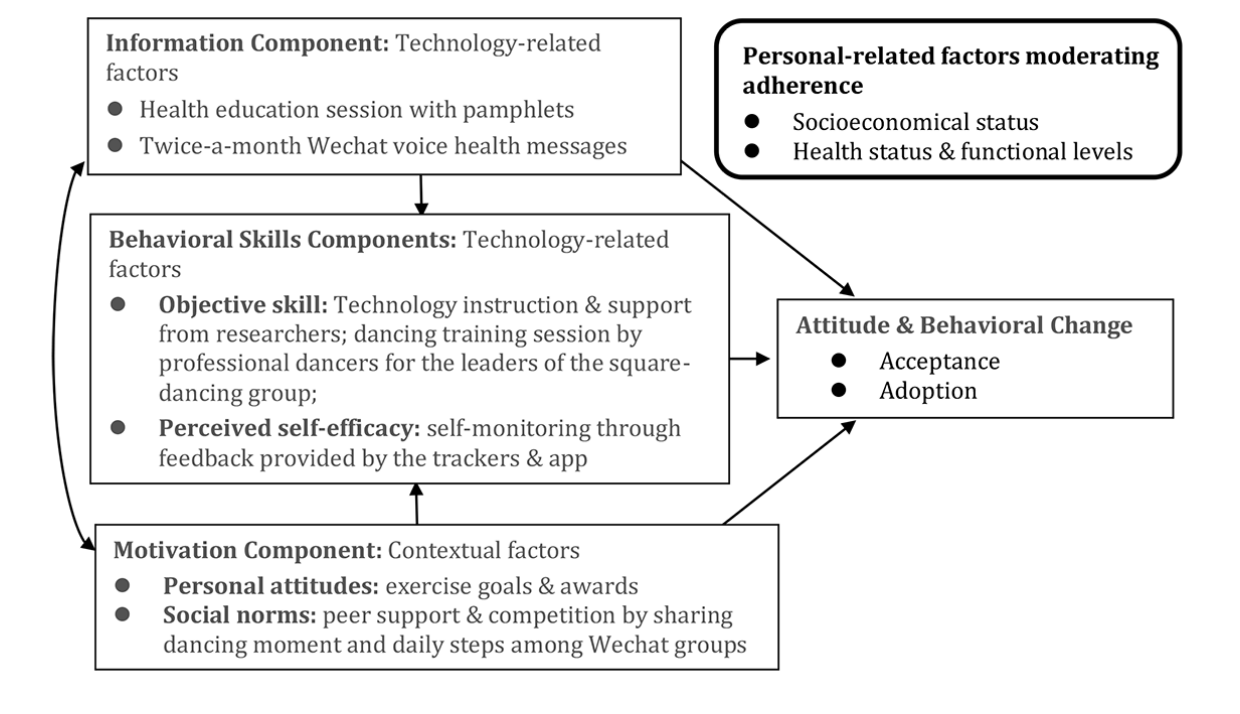
Figure 1. The Information-Motivation-Behavioral skills (IMBS) framework for intervention